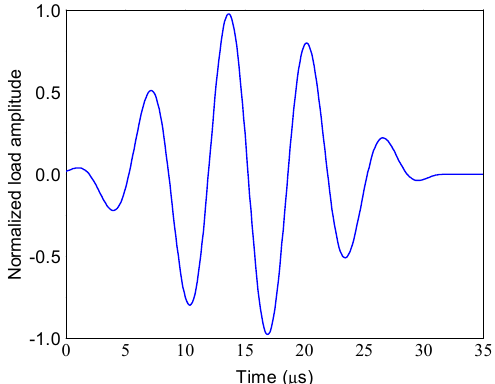
Figure 3. Actuator signal: 150 kHz five-cycle tone-burst sine pulse.